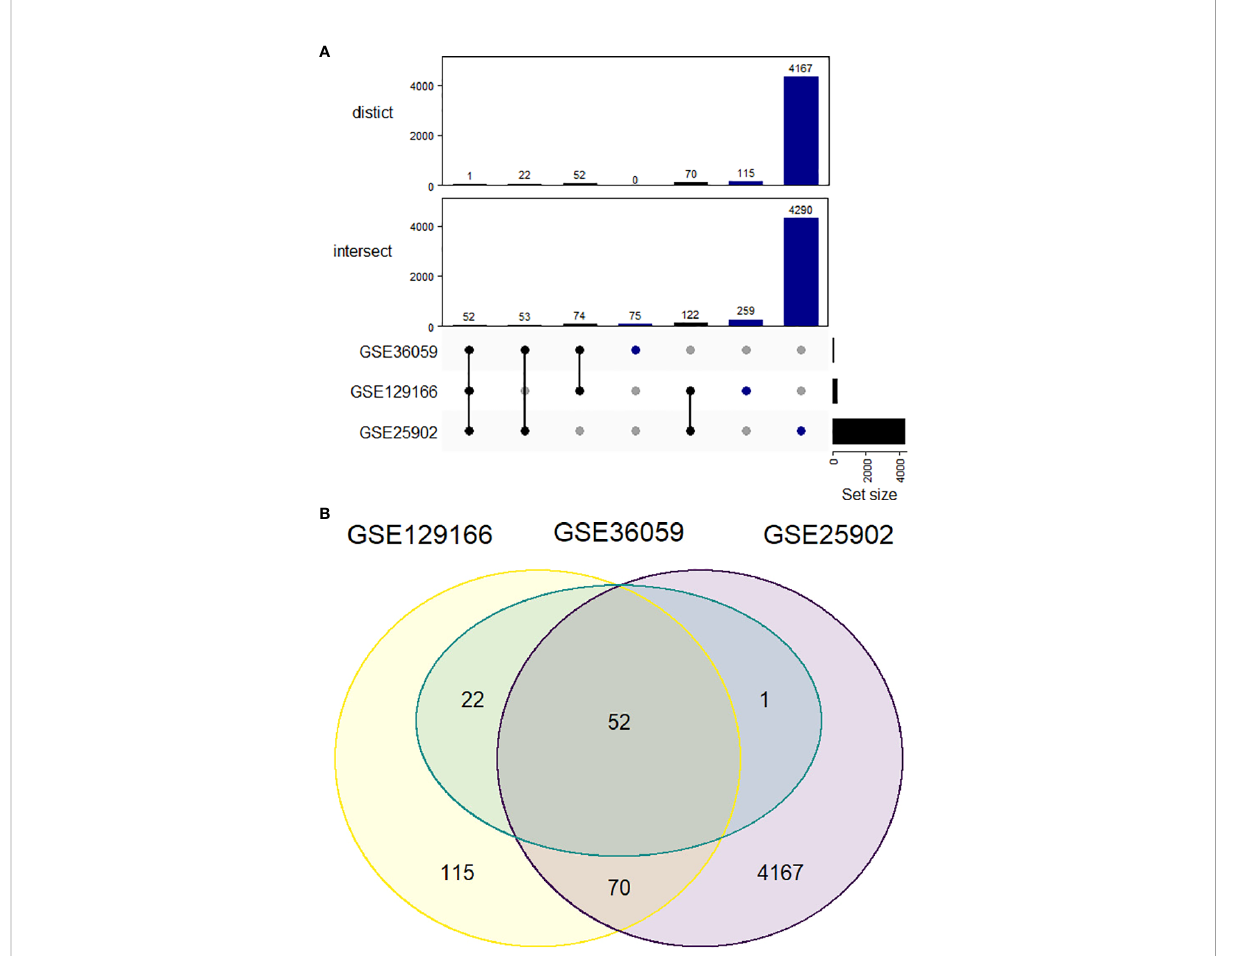
FIGURE 1 Upregulated differentially expressed genes comparing acute kidney rejection vs. stable graft. (A) Datasets represented by Venn diagram showing 52 overlapped genes between GSE25902, GSE36059, and GSE129166. (B) UpSetR representation of both intersect and distinct forms. The intersect method indicates whole gene similarity between compared studies, while distinct analysis plots the genes shared exclusively among each group of